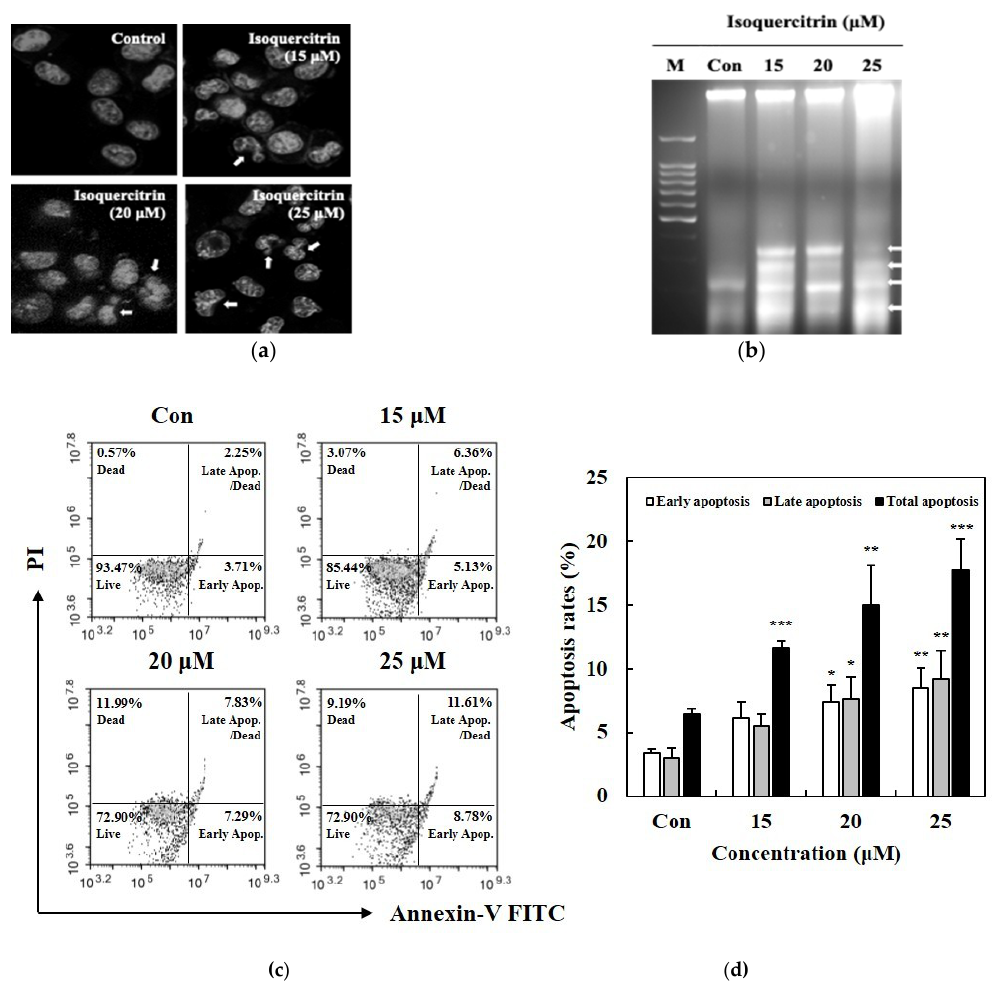
Figure 4. E ff ect of isoquercitrin on the apoptotic cell death of SK-MEL-2. The SK-MEL-2 cells were subjected to treatment with 15, 20, and 25 µ M of isoquercitrin. ( a ) Nuclear condensation and membrane blebbing (indicated by the arrows) as affected by the treatment with isoquercitrin was observed using the Hoechst assay. ( b ) DNA fragmentation was detected through agarose gel electrophoresis. ( c ) Apoptotic cell death was analyzed using the Annexin V / PI staining assay. ( d ) The percentage of apoptotic cells was quantified. Results are expressed as a percentage. Data values are expressed as mean ± SD of triplicate determinations. Significant difference was established using Dunnett’s test at * P < 0.05, ** P < 0.01 and *** P < 0.001. Accumulation of cells in the sub-G1 cell cycle phase as a result of apoptotic cell death was also analyzed through flow cytometry. Treatment with IQ resulted in the increase in the cell population in the sub-G1 phase in a dose-dependent manner as illustrated in Figure 5. Particularly, an increase to 19.87% in the number of cells that accumulated in the sub-G1 phase was detected upon treatment with 25 μM of IQ. These morphological and physiological changes in the cells manifested in the results of the experiments showed that IQ can induce apoptotic cell death in SK-MEL-2 melanoma cells.